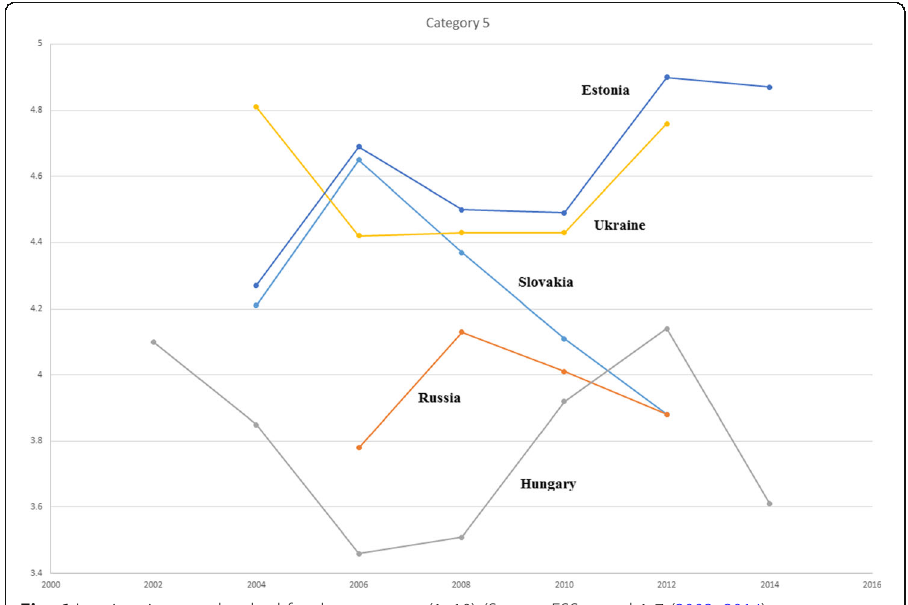
Fig. 6 Immigration good or bad for the economy (1 – 10) (Source: ESS round 1-7 (2002 –